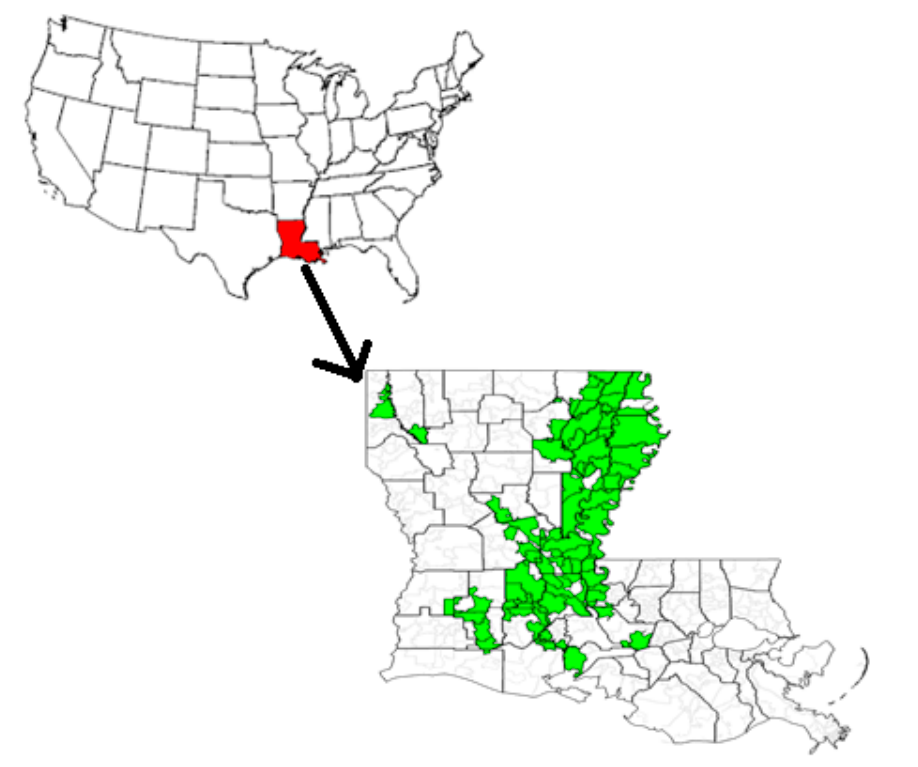
Figure 3. Map of the U.S. contiguous states with the State of Louisiana highlighted in red. The study area under consideration in Louisiana is shown in green.